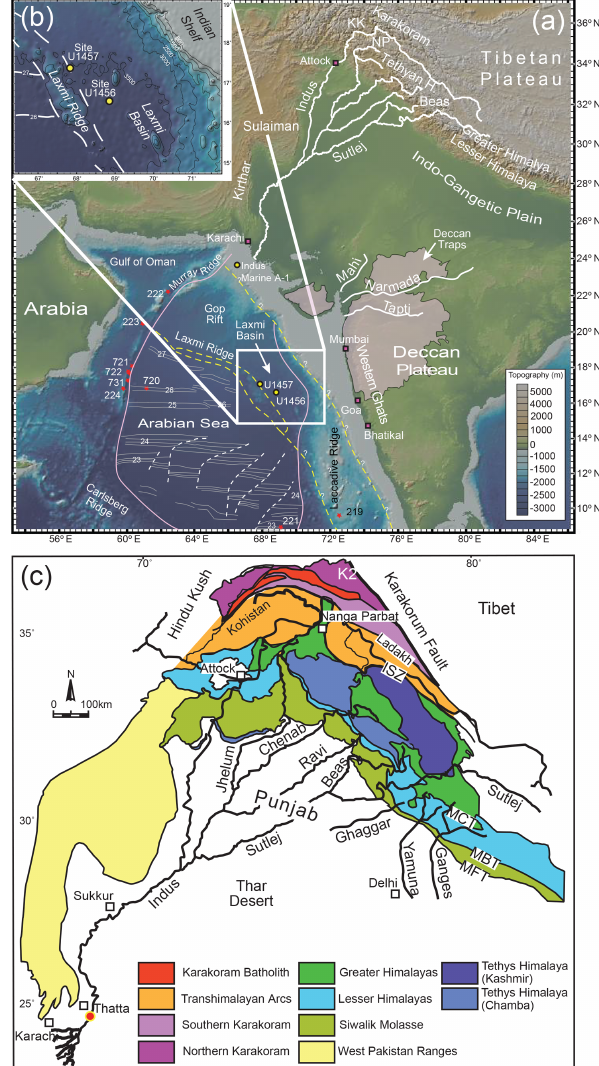
Figure 1. (a) Shaded bathymetric and topographic map of the Ara- bian Sea area showing the location of the drilling sites within the Laxmi Basin, considered by this study. Map also shows the pri- mary source terranes and the major tributary systems of the In- dus River, as well as smaller Indian Peninsula rivers that may have provided material to the drill sites. (b) Inset map shows detail of the Laxmi Basin and location of the drill sites considered in this study. Numbered red circles indicate existing scientific boreholes from the Deep Sea Drilling Project (DSDP) and Ocean Drilling Pro- gram (ODP). Magnetic anomalies are from Miles and Roest (1993). White dashed lines show transform faults. KK: Karakoram; NP: Nanga Parbat. (c) Geological map of the Western Himalaya show- ing the major tectonic units that are eroded by the Indus River and its tributaries. Map is modified after Garzanti et al. (2005). Rivers are shown in thick black lines. ISZ: Indus suture zone; MCT: Main Central Thrust; MBT: Main Boundary Thrust; MFT: Main Frontal Thrust. Thick black line shows the boundary of the Indus drainage, while thinner lines demark the limits of the major Himalayan tribu-